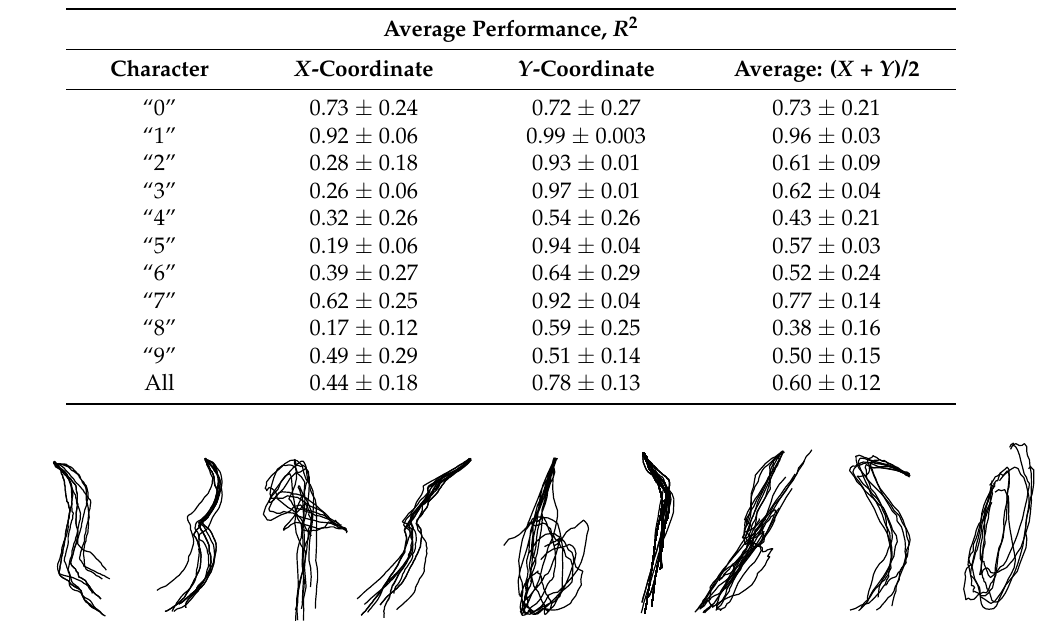
Table 5. Between-group reconstruction performance by the KF-GEP: the average accuracy of each numeric character across the five subjects.